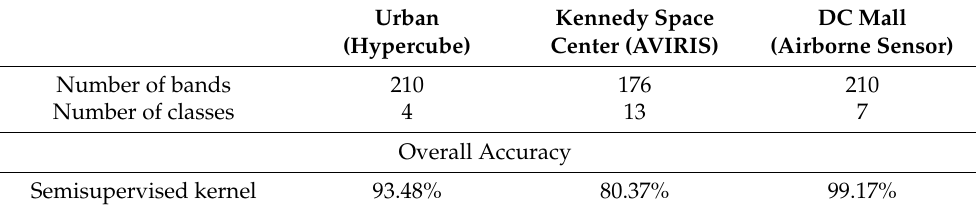
Table 9. Overall accuracy of a semisupervised kernel with K-means on three different datasets. Kennedy Space Cen- Urban (Hypercube) ter (AVIRIS) Sensor)